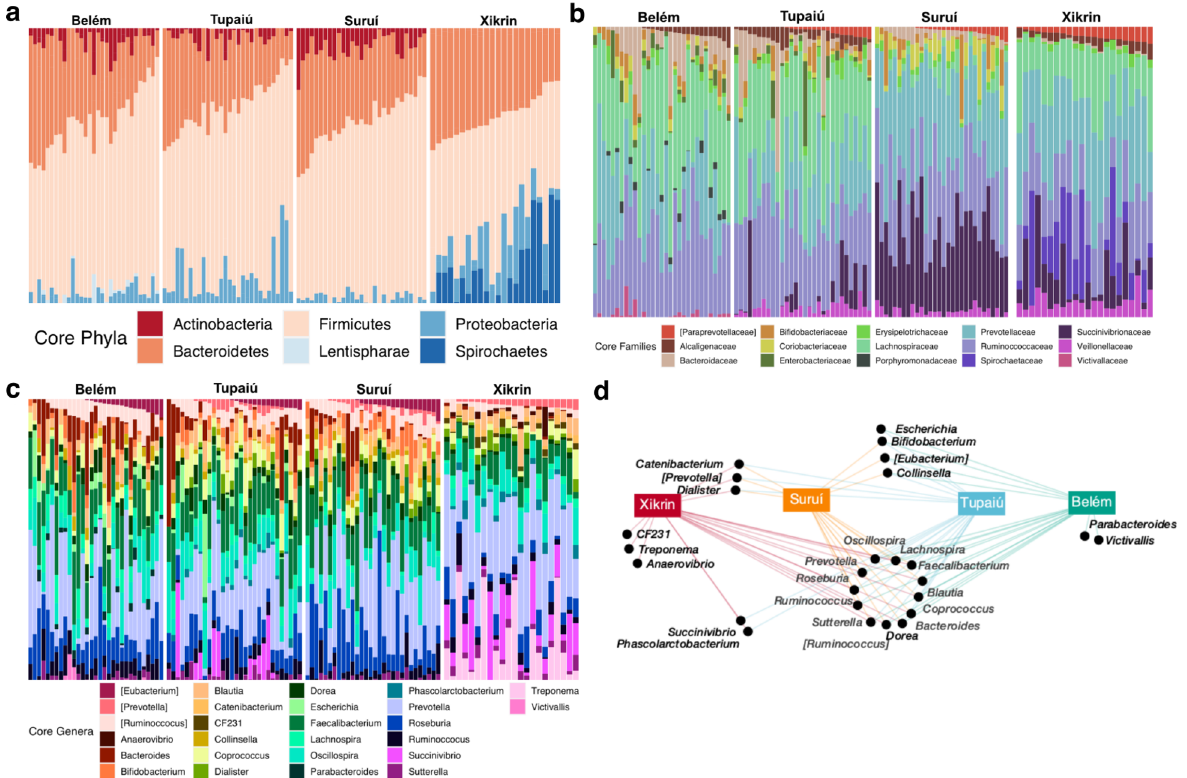
Fig. 3 Core microbiome distribution. a Abundance of core microbiome phyla per population. b Abundance of core microbiome families per population. c Abundance of core microbiome genera per population. d Network of the shared core microbiome genera in each